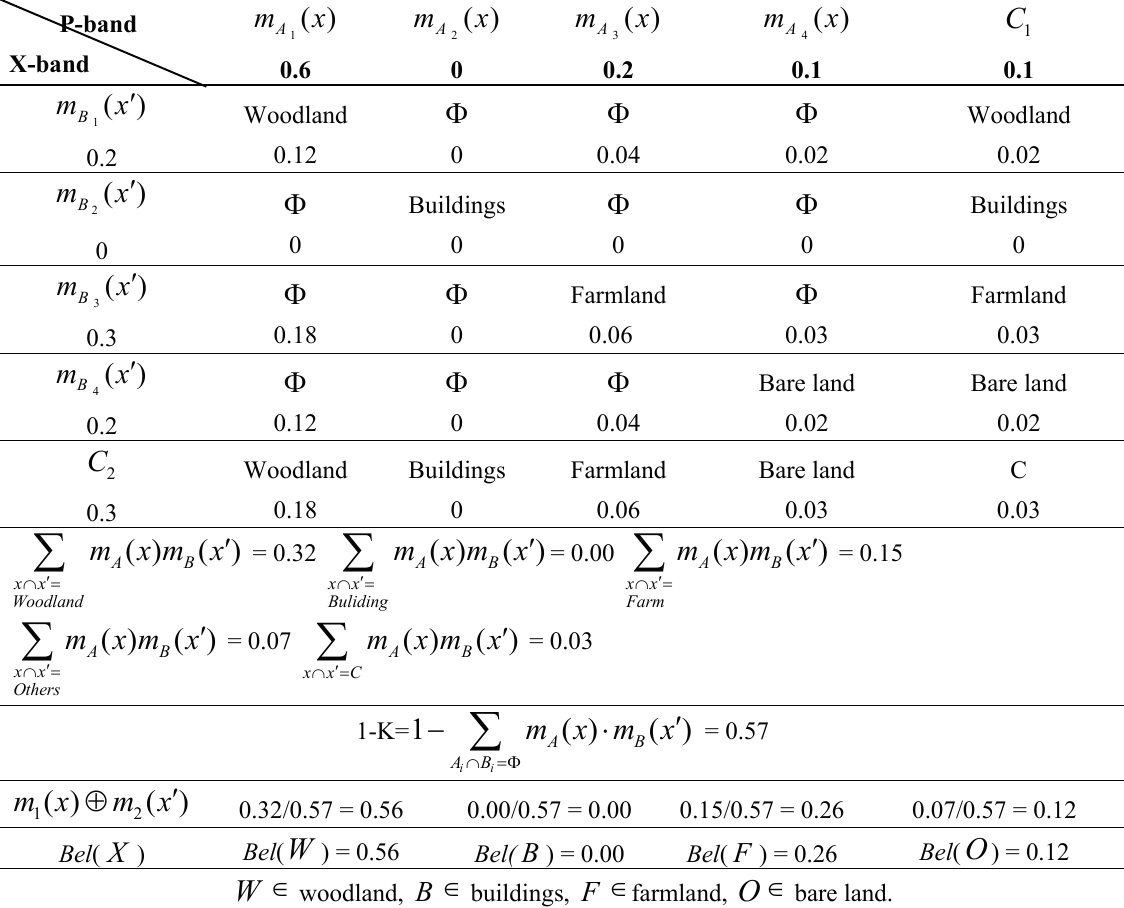
Table 3. Combination and decision results of four